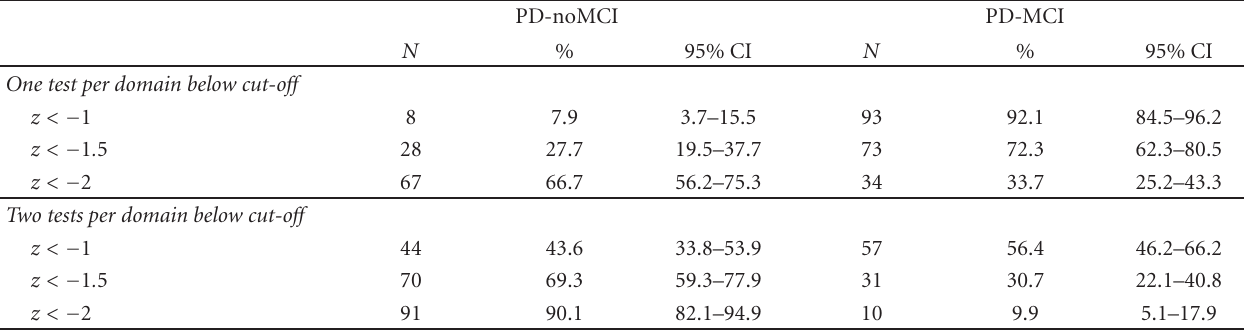
Table 2: Percentage (including 95% confidence interval, 95% CI) of Parkinson patients with minimal cognitive impairment (PD-MCI) and without (PD-noMCI) in regard to varying cut-o ff values.